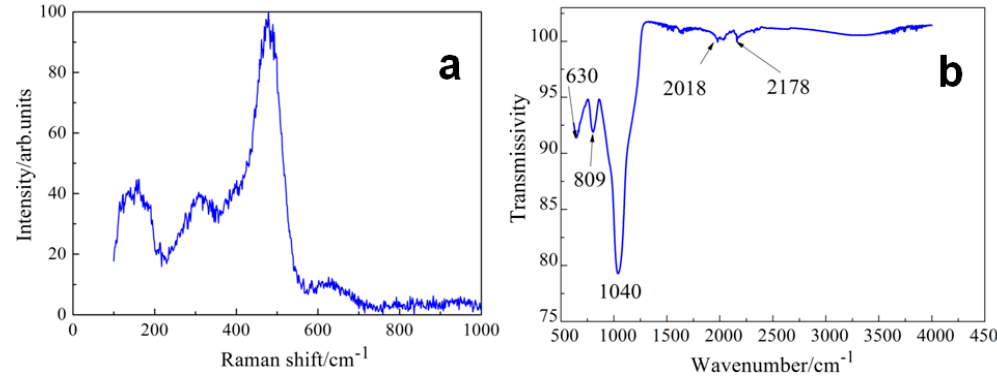
Figure 1. ( a ) Raman and ( b ) FTIR spectrum of a-Si:H films.